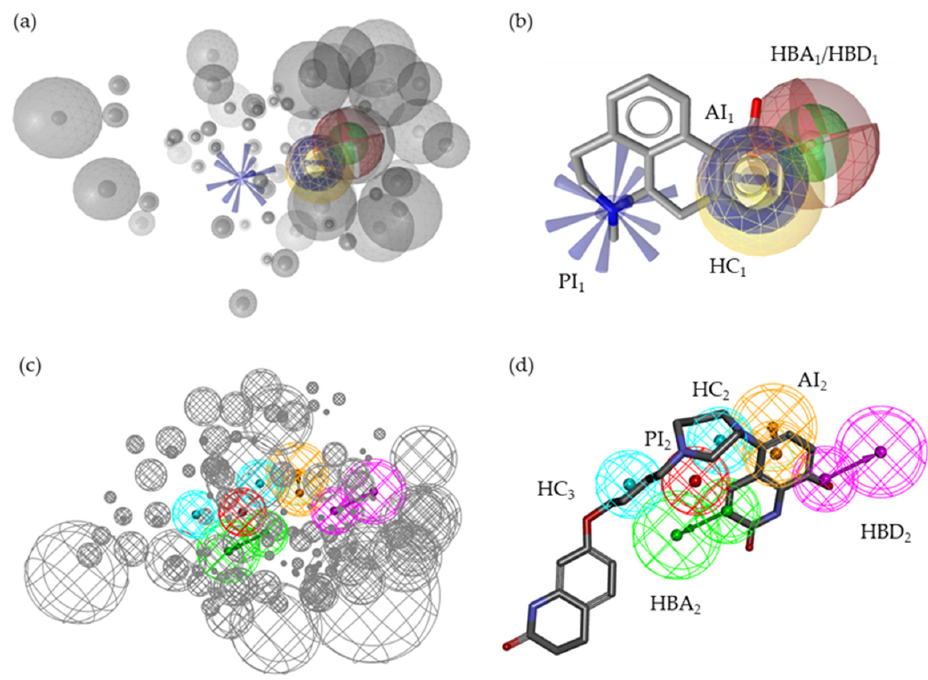
Figure 5. Ligand-based pharmacophore models M3 and M4 generated using LS and DS, respectively. Both models were based on 1 , SC52 , and SC59 . ( a ) Display of M3 including 61 exclusion volumes (XVOLs). ( b ) M3 aligned with 1 . ( c ) Display of M4 including 122 XVOLs. ( d ) M4 aligned with SC59 . XVOLs (grey). Hydrophobic contacts (HCs; yellow and cyan spheres). Hydrogen bond acceptor (HBA; red and green spheres). Hydrogen bond donor (HBD; green and purple sphere). Positively ionizable interaction (PI; blue star-like shape, red sphere). Aromatic interaction (AI; blue circle, orange sphere). All features represent characteristics of the respective structural features of the investigated